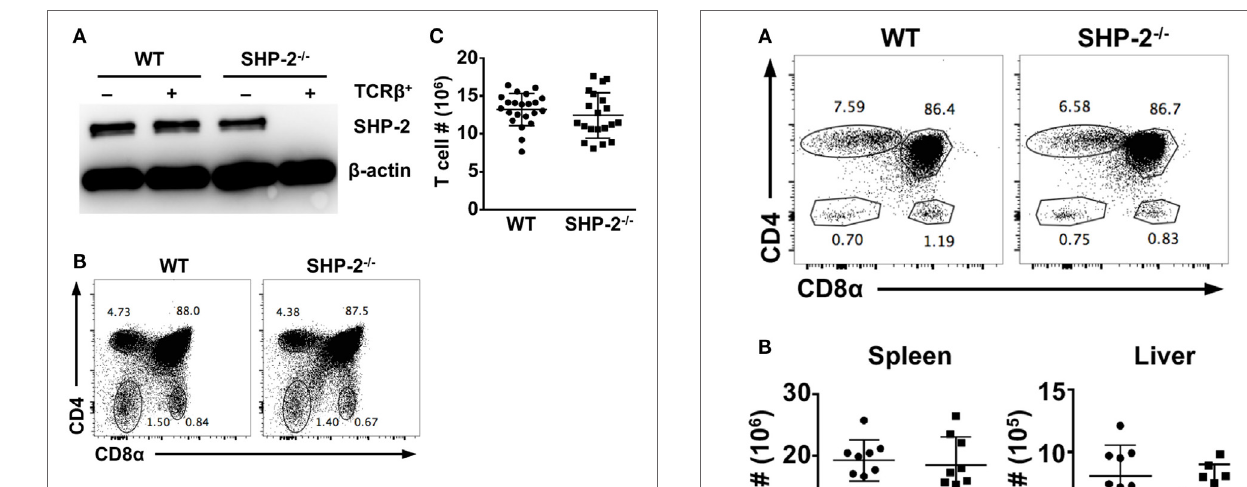
FigUre 1 | Src homology region 2 domain-containing phosphatase-2 (SHP-2) deficiency does not affect T cell development. (a) SHP-2 expression in splenocytes was evaluated by Western blot. YFP + CD3 + TCR β + and YFP − CD3 − TCR β − splenocytes were sorted from wild-type (WT) and SHP-2 − / − mice. Cellular lysates were blotted with α -SHP-2 and anti- β -actin antibodies. (B) Representative FACS plots show thymic T cell development in WT and SHP-2 − / − mice. (c) Number of T cells in the spleen of SHP-2 deficient and littermate controls.